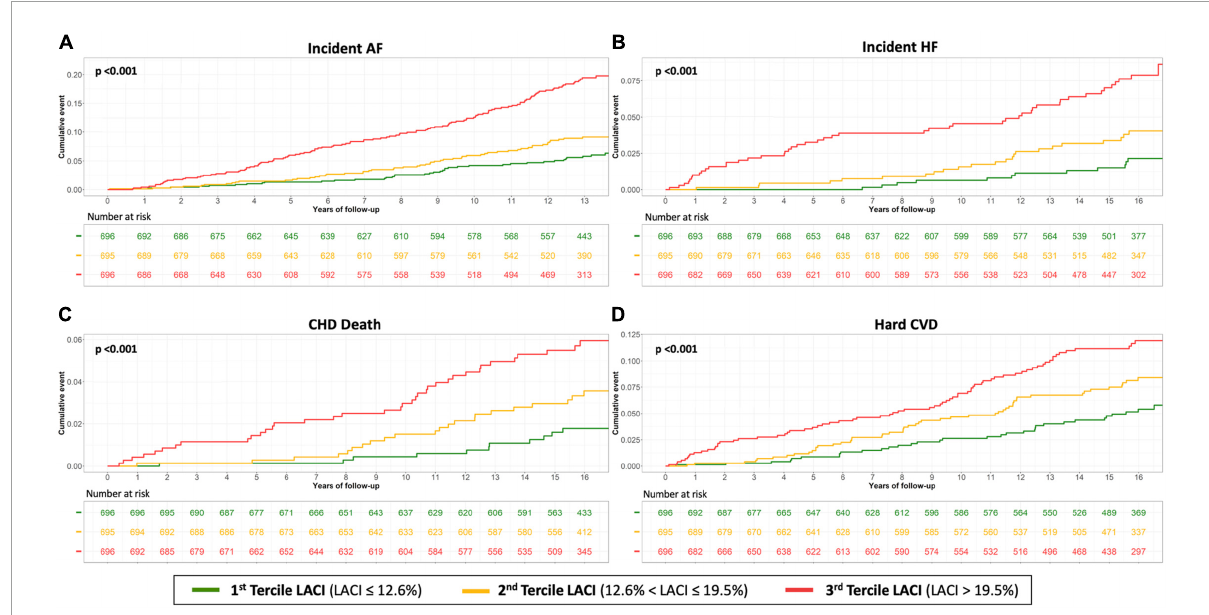
FIGURE4 Kaplan–Meier survival curves for incident AF (A) , incident HF (B) , CHD death (C) and hard CVD (D) by LACI terciles in all women. The cumulative hazard was systematically significantly greater in the third quartile compared with the other terciles for each outcome (log-rank for difference; p < 0.001).